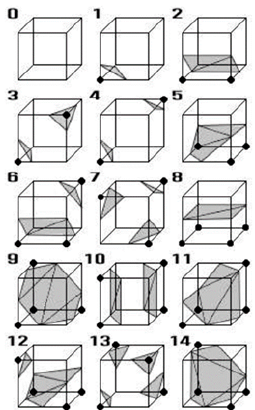
Figure 3. The configuration of marching cubes based on [6].